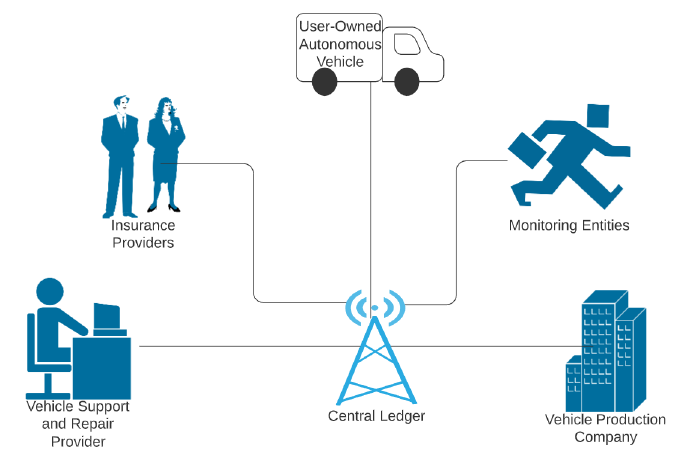
Figure 16. Different types of users who may have permission to operate on or with accident-related data, inspired by